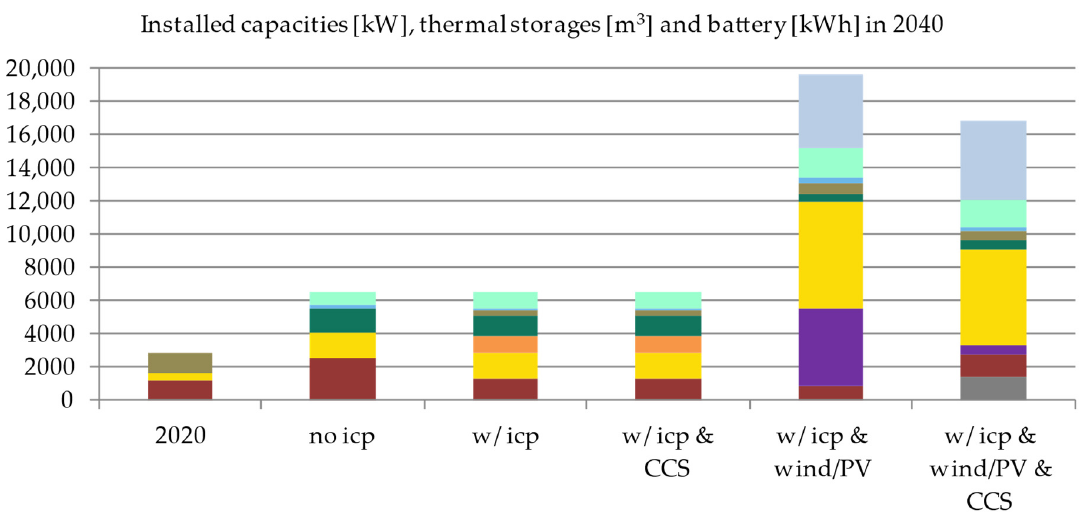
Figure 7. Installed capacities for the British scenarios in 2040.